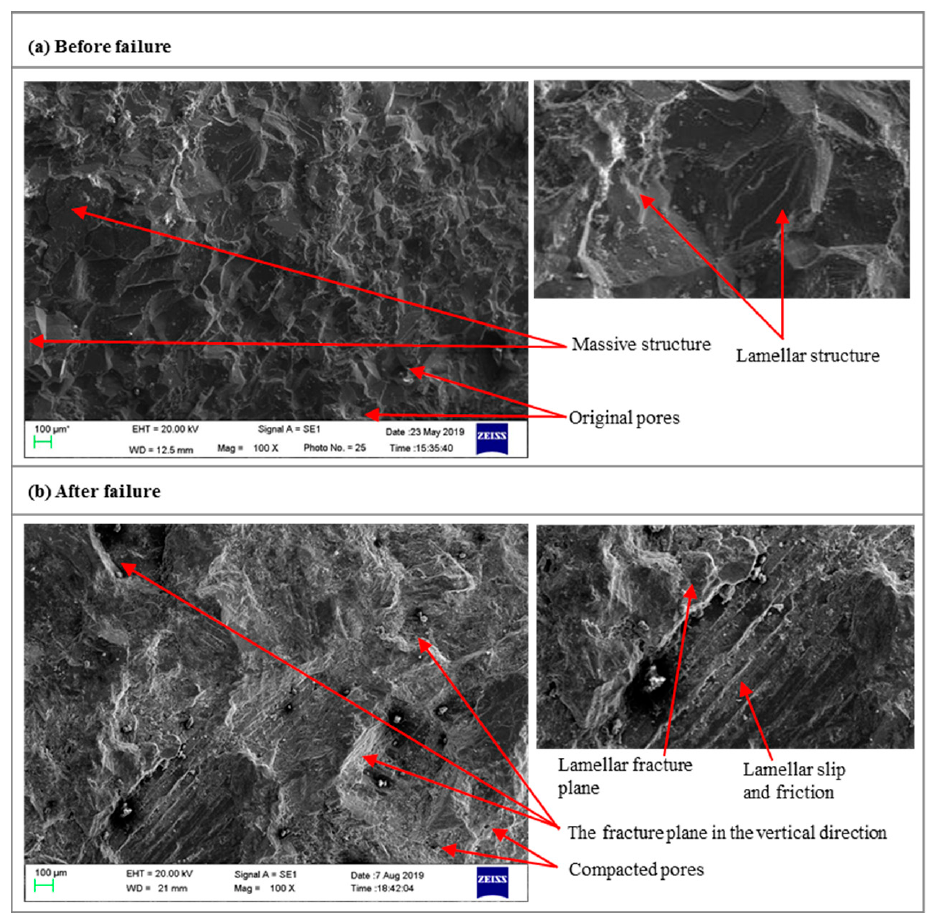
Figure 16. Observation on the fracture surface of the IRC sample before and after failure by SEM. ( a ) Before failure: the granulite was mainly composed of a dense block and a layered structure, as well as some pores, ( b ) After failure: the fracture mainly exhibited friction, double-slip, and layered-slip morphology, pores are compacted.